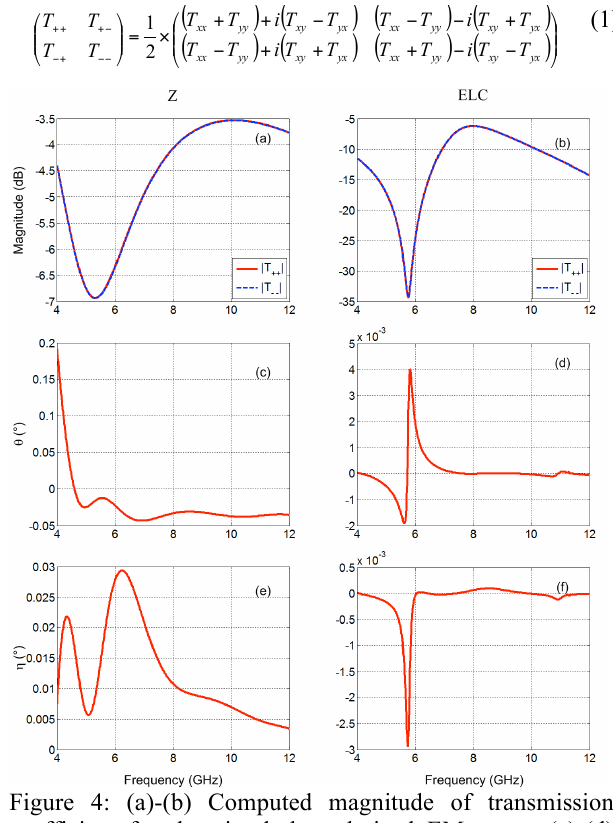
Figure 4: (a)-(b) Computed magnitude of transmission coefficient for the circularly polarized EM wave, (c)-(d) Computed polarization azimuth rotation ( θ ) , (e)-(f) Computed ellipticity angle ( η ) for the Z-shaped and ELC resonators